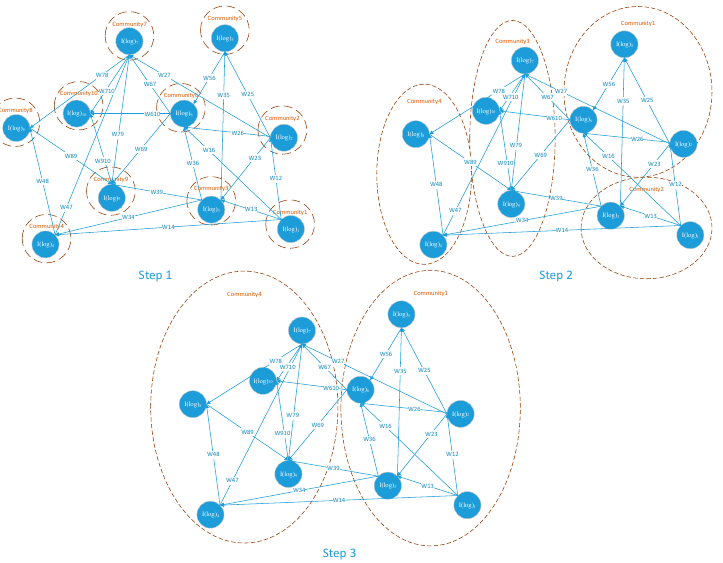
Figure 8. The optimization procedure of log instance communities.